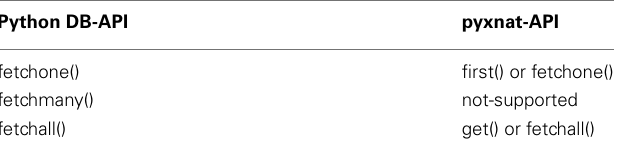
Table 3 | Cursor objects methods comparison.